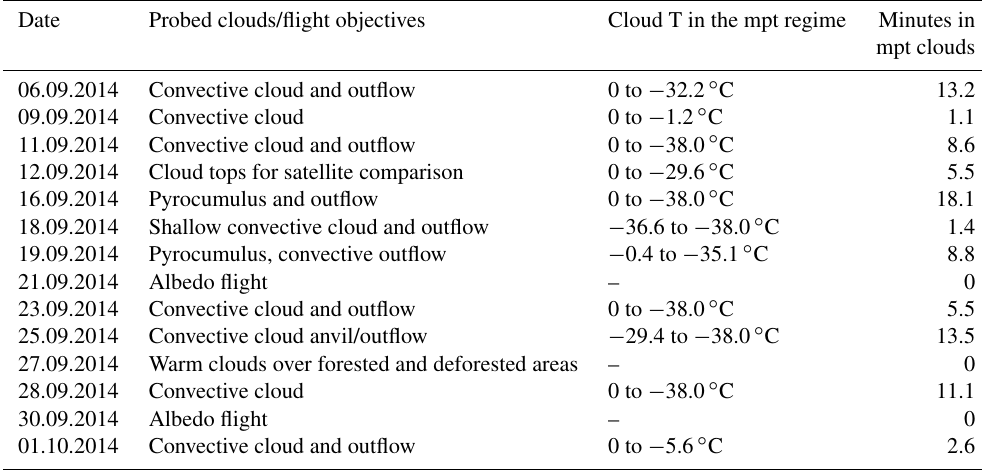
Table 5. Flight table for ACRIDICON–CHUVA. Dates are